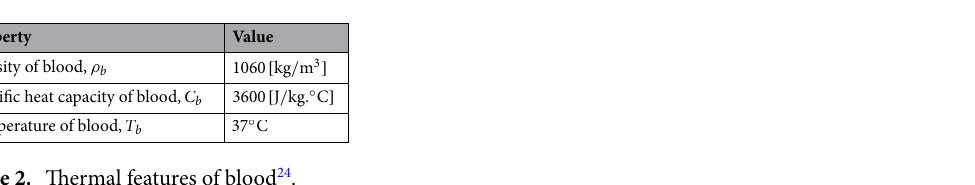
Table 2. Thermal features of blood 24 .